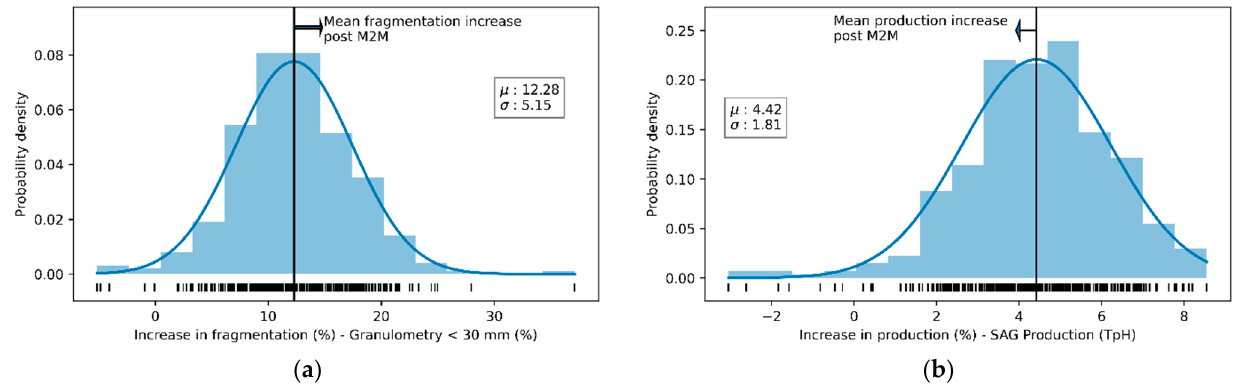
Figure 8. Distribution of the percentage of fragmentation improvements or the percentage of ore in feed < 30 mm ( a ) and the percentage increase in the SAG mill’s production in TpH ( b ). In addition to quantifying the impact of M2M on production at +4.42% TpH, the model obtained − 7.62% energy savings in the SAG mill (see Figure 9a). The ML model suggests that there would be the potential to increase TpH production by an additional 1% if the percentage of fine mineral increases (that is, fragmentation increases from 41% to 46%), prior to technical evaluation developed by the geology field. Then, the model suggests that the cost of the additional fragmentation delta derived from the comminution phases before SAG grinding could be quantified, which must be contrasted with the potential incremental profit of 1% in production using the M2M strategy (see Figure 9b).